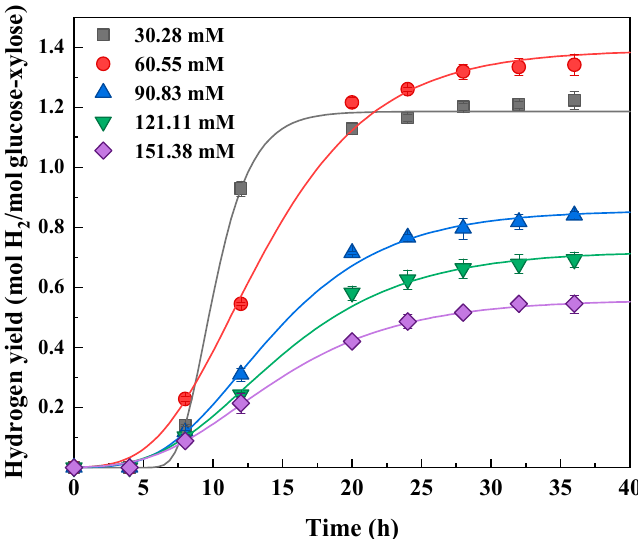
Figure 3. Cumulative bio-hydrogen yield from glucose–xylose at varying substrate concentrations with simulation curves based on the modified Gompertz equation.